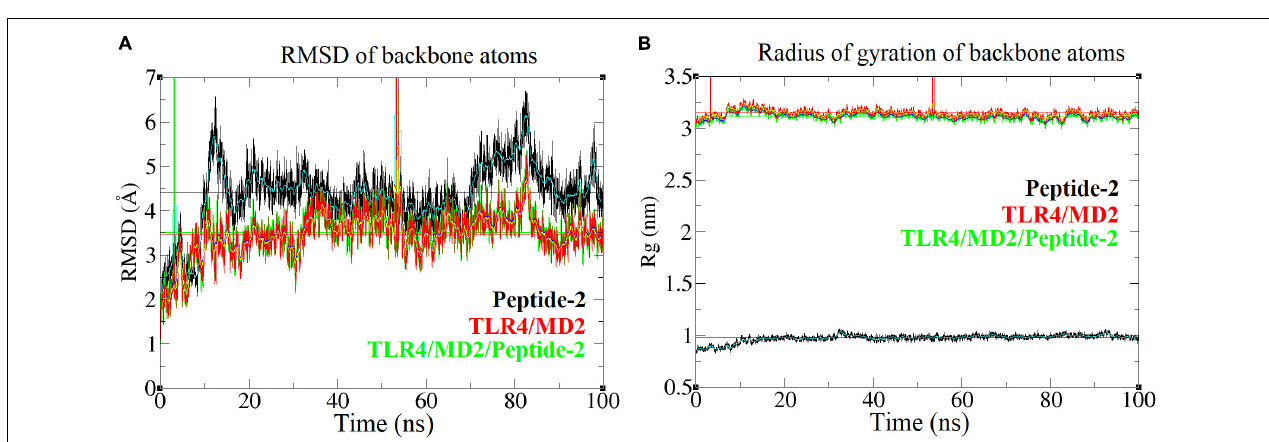
FIGURE 5 | Root mean square deviation and radius of gyration of different backbone molecules of the TLR4/MD2/Peptide-2 complex simulated by MD at 310 K for 100 ns. (A) Root mean square deviation or RMSD (nm, Y axis) vs. time (ns, X axis) plot, (B) Radius of gyration or Rg (nm, Y axis) vs. time (ns, X axis) plot light blue, navy blue, and yellow lines represent the average value between each simulation step. To calculate and plot the RMSD, the MD resulting conformations were previously aligned using the “Trajectory tool” of VMD package (42). Vertical green and red lines are due periodic boundary effects.